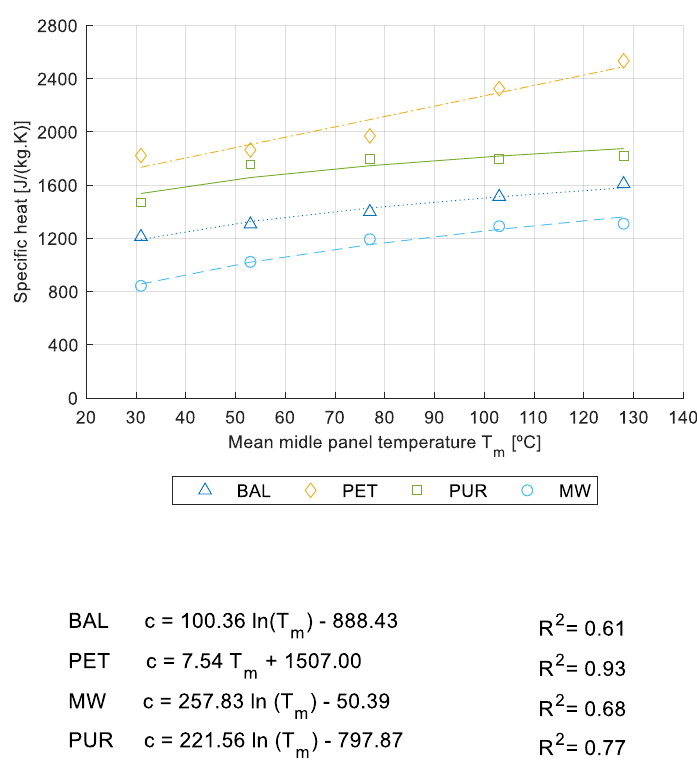
Figure 11. Specific heat/mean temperature register.